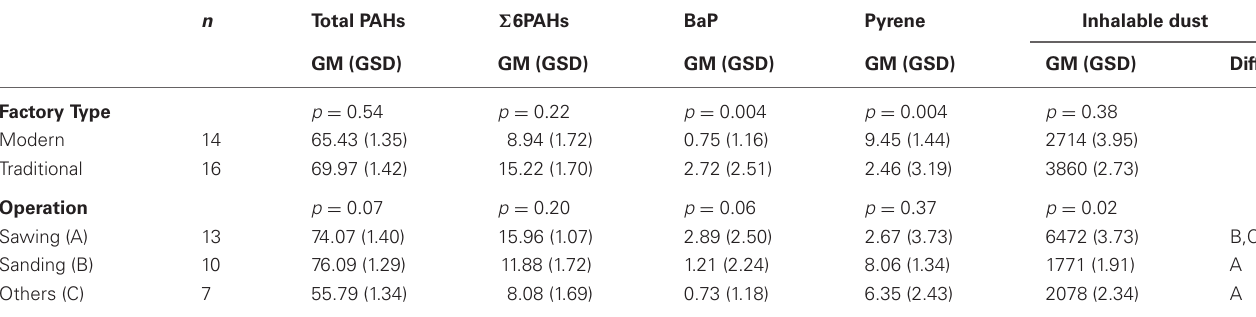
Table 3 | Personal exposures to total PAHs, (cid:2) 6PAHs, BaP, and pyrene concentrations (ng m − 3 ) found in inhalable wood dust, and inhalable dust concentrations ( µ g m − 3 ) by factory type and operation.